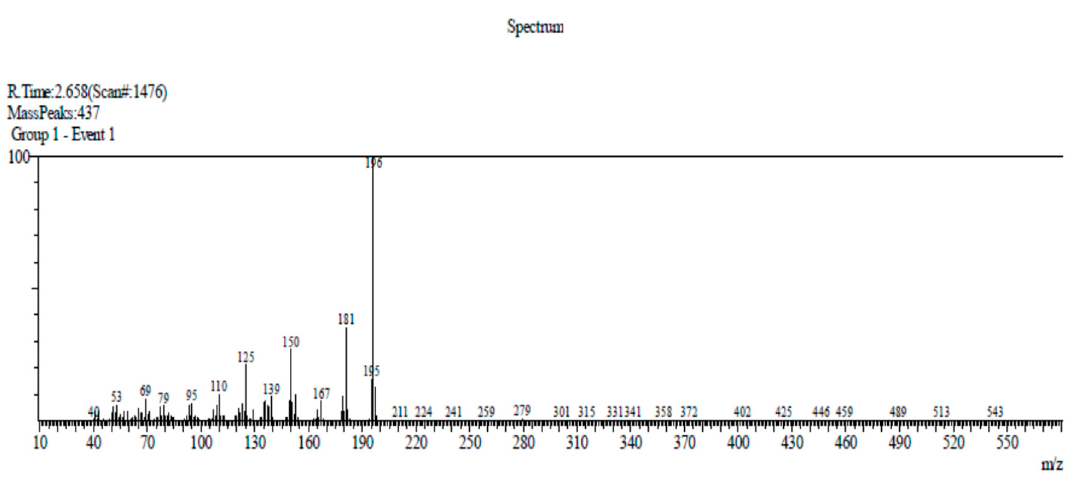
Figure 3. DIP-MS spectrum of asaronaldehyde.